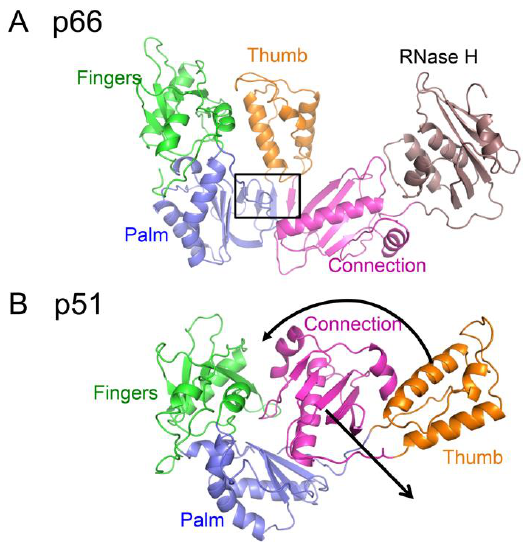
Figure 2. Alternative structures of the metamorphic polymerase domain. ( A ) The extended structure observed in the p66 E subunit of RT; ( B ) the compact structure observed in the p51 subunit of the RT heterodimer. Color coding is: fingers (green); palm (blue); thumb (orange); connection (magenta). The position of the RH domain in the p66 subunit is also shown (brown), although this domain does not participate in the metamorphic rearrangement. The extended conformation includes a short, four-stranded β -sheet that forms part of the palm:connection interface in the extended conformation (boxed) that is not present in the compact conformation. Black arrows indicate the major domain rearrangements that need to occur for the metamorphic transition.